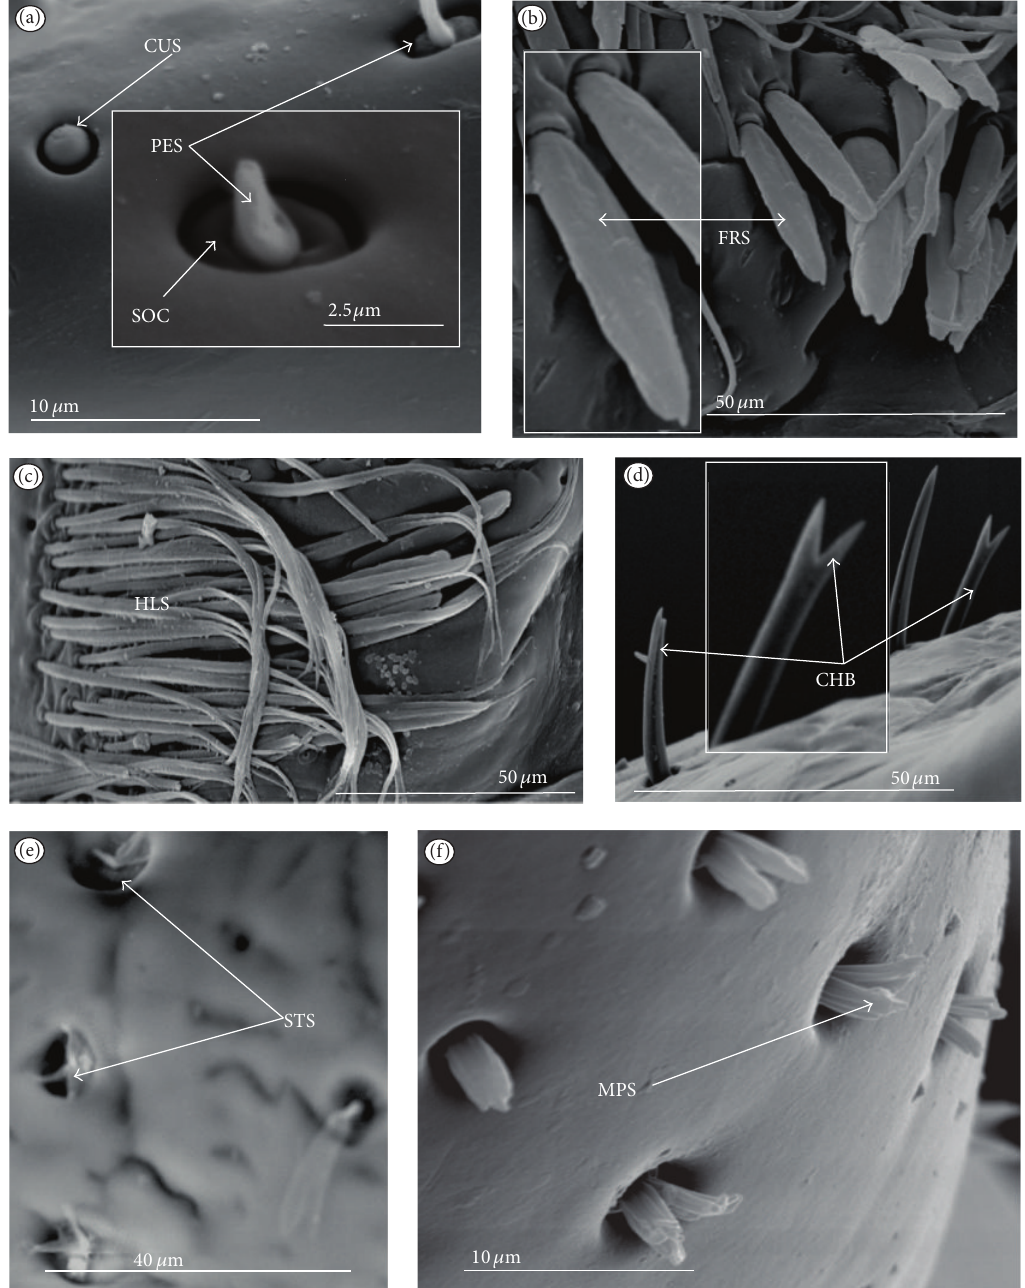
Figure 2: Types and sizes of the labial mechanosensilla of the Nepomorpha. (a) CUS cupola sensillum, PES peg sensillum. (b) FRS finger-like sensillum. (c) HLS freniale-like sensillum. (d) CHB chaetic sensillum with a bisected tip. (e) STS star-like sensillum. (f) MPS multilobed